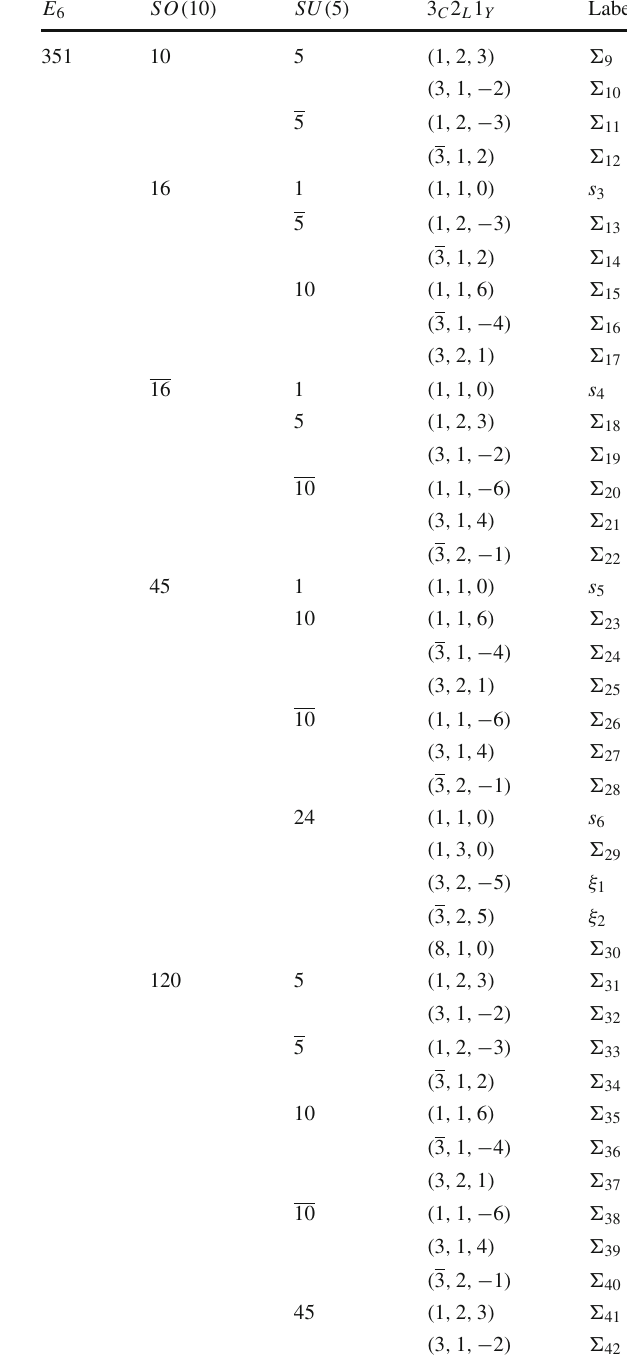
Table 8 Decomposition of the 351 representation of E 6 with respect to the subgroups SO ( 10 ) , SU ( 5 ) and SU ( 3 ) C × SU ( 2 ) L × U ( 1 ) Y . For further details, see Table